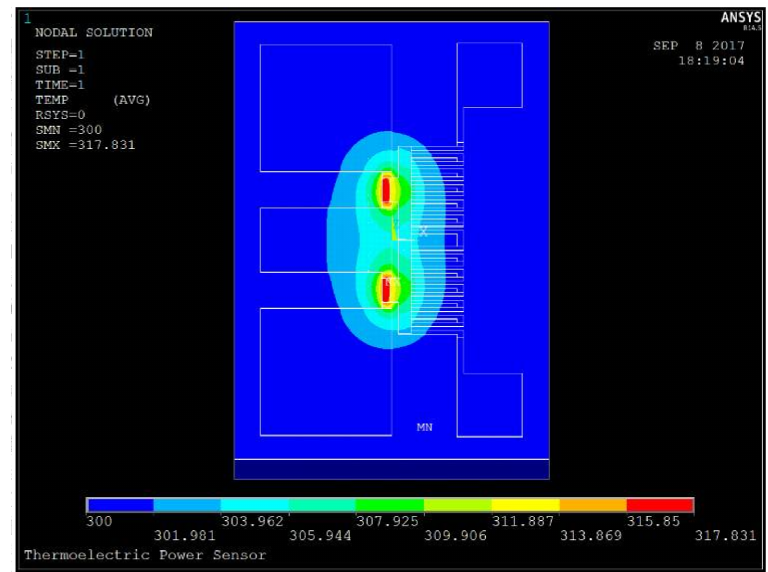
Figure 4. Simulated temperature distribution of the power sensor with the dual thermal flow paths under the power level of 100 mW.